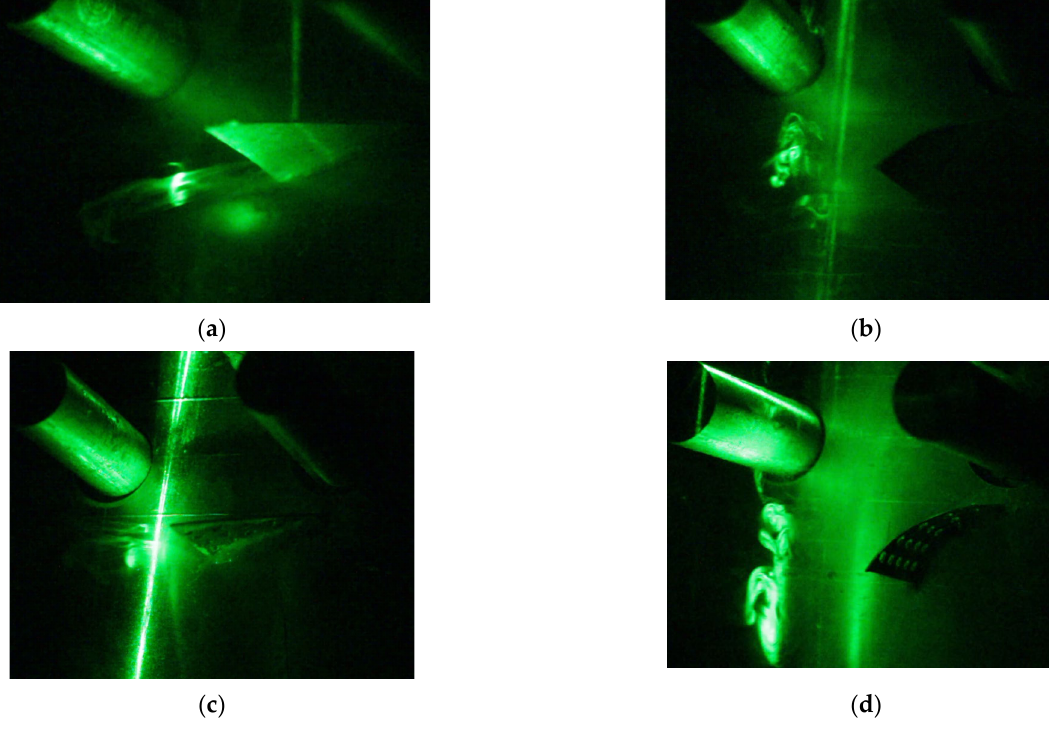
Figure 8. Visualization of the LV in the cross-section of the flow in the installation: ( a ) DWP, ( b ) CDWP, ( c ) PDWP, and ( d ) PCDWP VGs at the flow velocity of 1 m/s.